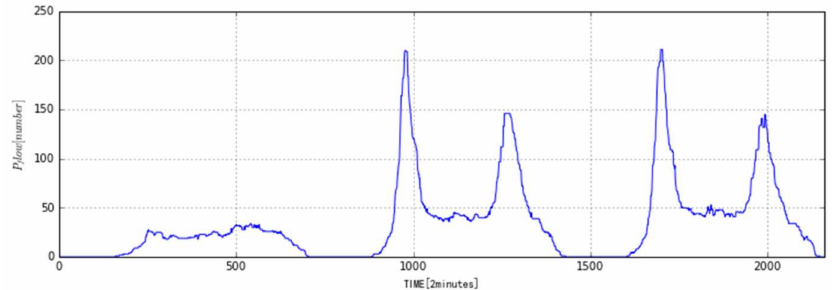
Figure 4. Processed passenger flow data.